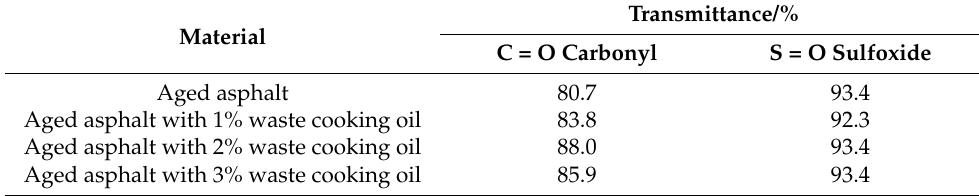
Table 19. Intensity o of key functional group [68].